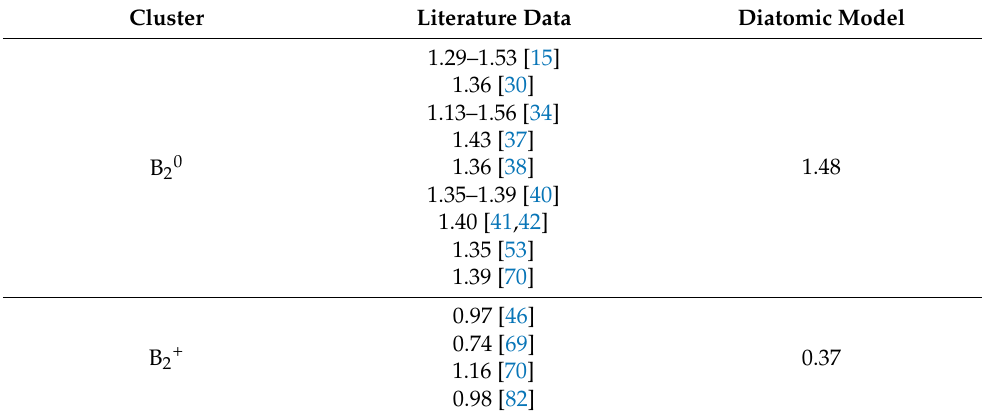
Table 2. Comparison of the literature data on specific binding energies (in eV) of boron small clusters with values calculated in diatomic